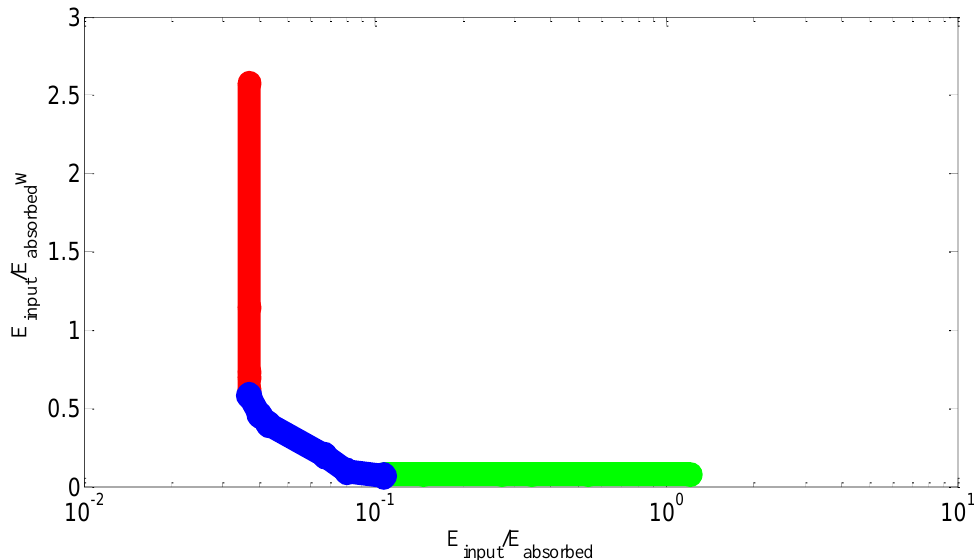
Fig. 9. Pressure impulse curve for SDOF system subjected to blast load on front wall.